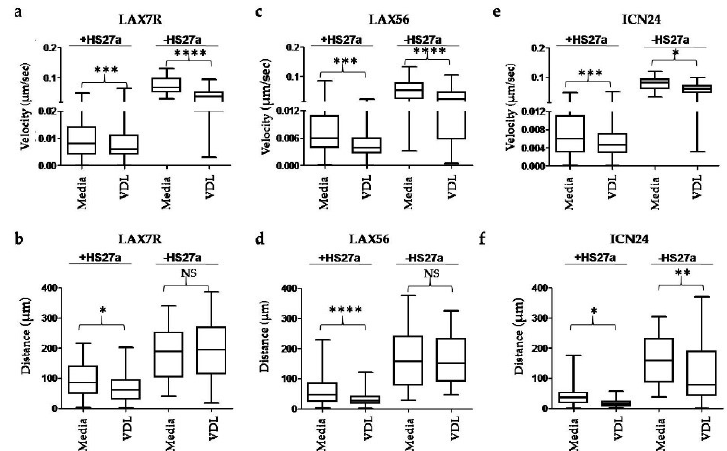
Figure 3. E ff ect of chemotherapeutic treatment of primary ALL cells cocultured with human stromal cells on velocity and migratory distance. Velocities of ( a ) LAX7R, ( c ) LAX56, and ( e ) ICN24 cells treated with medium or VDL. Cells were co-cultured with HS27a human stromal cells ( + HS27a) or not (-HS27a). The migration distance from the origins of the ( b ) LAX7R, ( d ) LAX56, and ( f ) ICN24 cells that were or were not cocultured with HS27a cells was also measured. * p < 0.05, ** p < 0.01, *** p < 0.001, and **** p < 0.0001 when compared with their corresponding medium controls (unpaired t -test). NS, not significant.